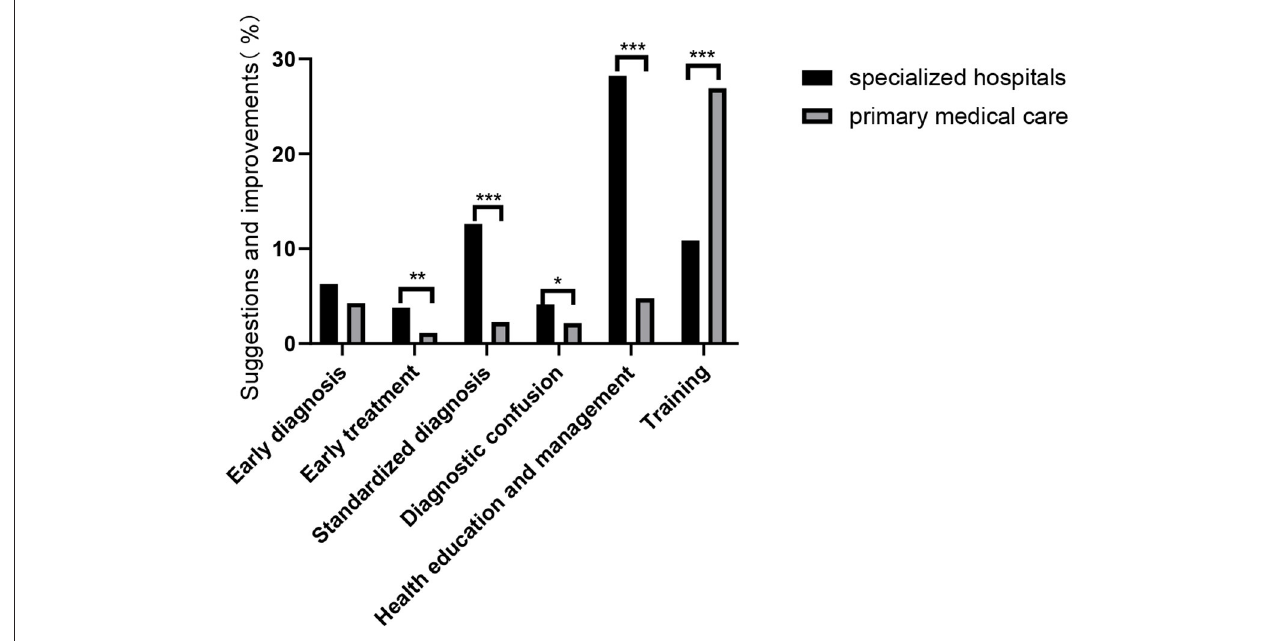
FIGURE 5 | Education regarding and management of CVA and CTVA. Suggestions for improvements by physicians in specialized hospitals and primary medical care facilities. * P < 0.05, ** P < 0.01, *** P <